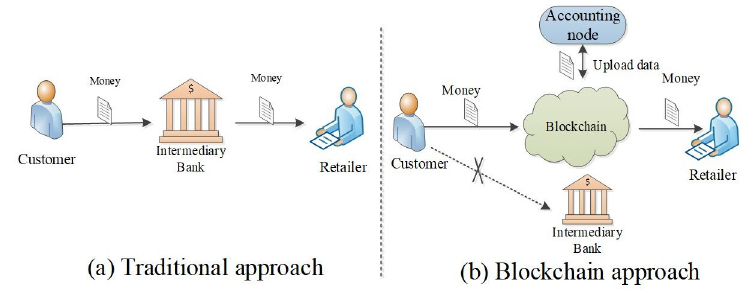
Fig 5. The comparison of transaction fee